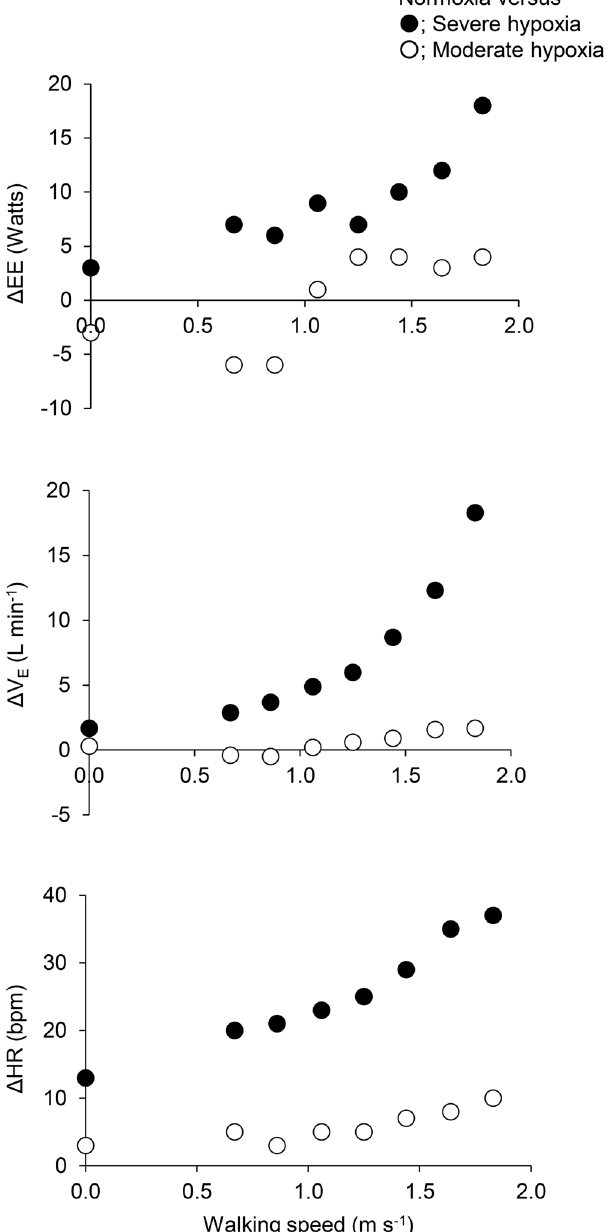
Figure 1. Mean values of differences in energy expenditure (EE: top panel), pulmonary ventilation (V E : middle panel), and heart rate (HR: bottom panel) between normoxic trial and moderate hypoxia (open circles), and between normoxic trial and severe hypoxia (filled circles) at rest and each walking speed. The number of 0.0 on the X axis indicate at